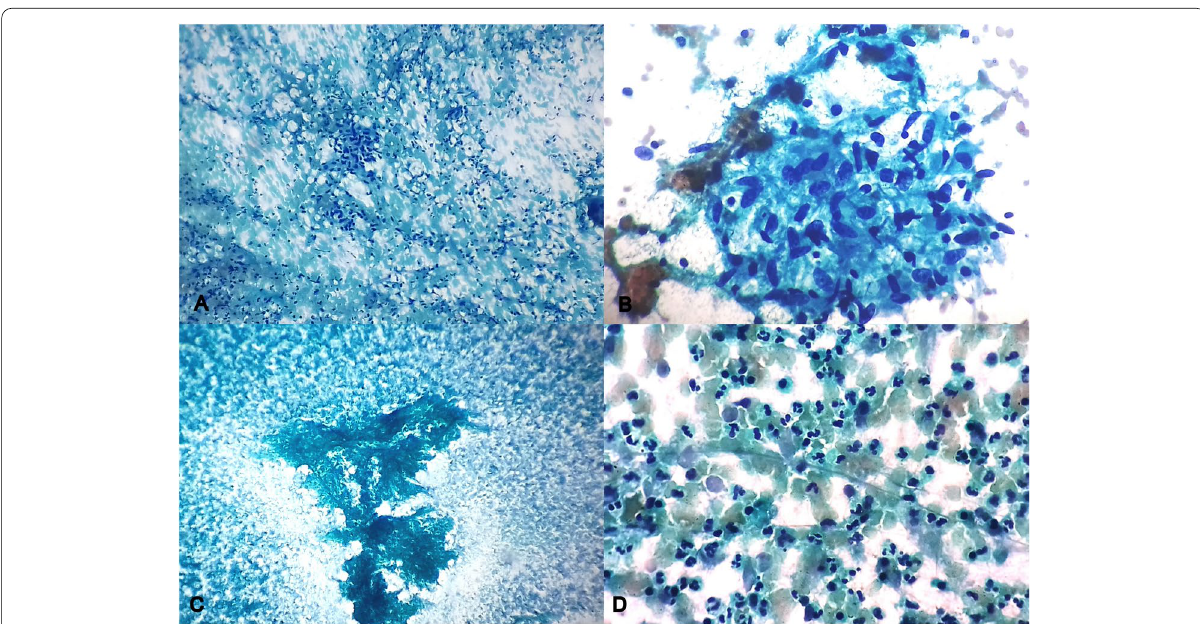
Fig. 1 Photomicrograph showing A ) Epithelioid cell granuloma admixed with lymphocytes, and caseous necrosis (Papanicolaou stain, 40x); B ) Only epithelioid cell granuloma (Papanicolaou stain, 10x); C ) Only caseous necrosis (Papanicolaou stain, 10x); D ) acute suppuration (Papanicolaou stain,